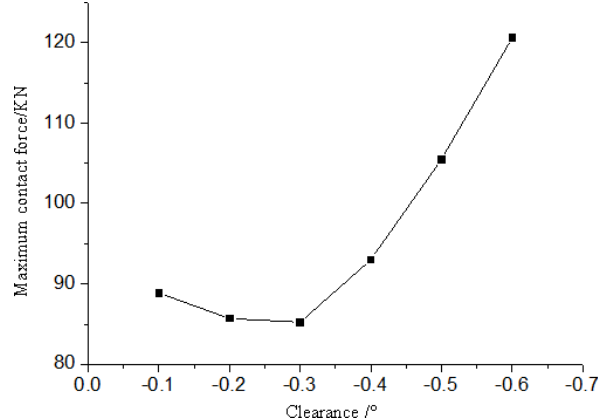
Figure 11: Effects of clearance on the maximum contact force